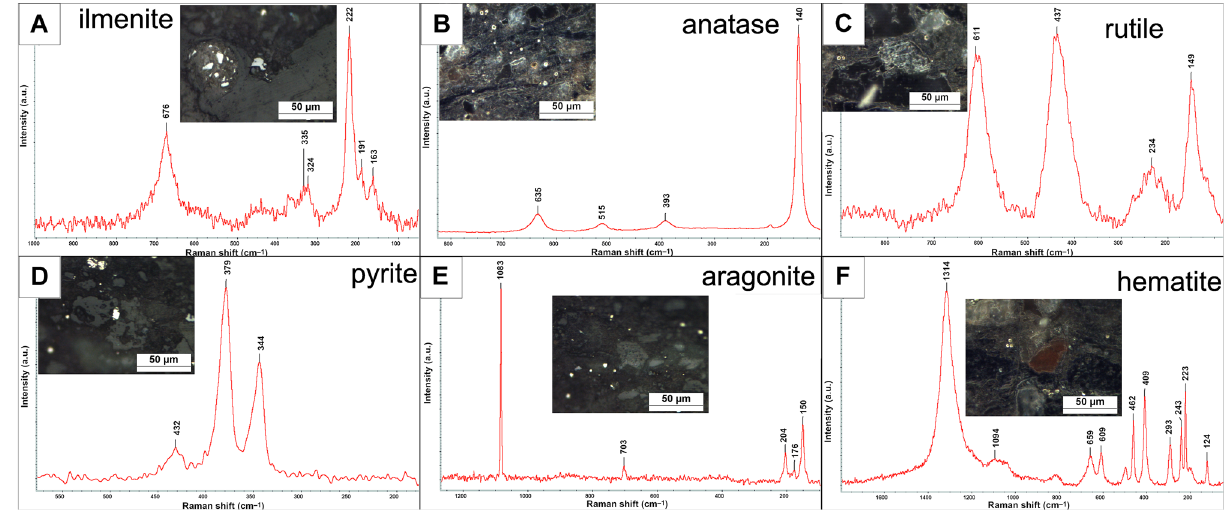
Figure 7. Raman spectra of the compounds of amber-bearing sediments. ( A ) Ilmenite (SC4 sample); ( B ) anatase (SC4 sample); ( C ) rutile (SC4 sample); ( D ) pyrite (SC1 sample); ( E ) aragonite (SC1 sample); ( F ) hematite (SC4